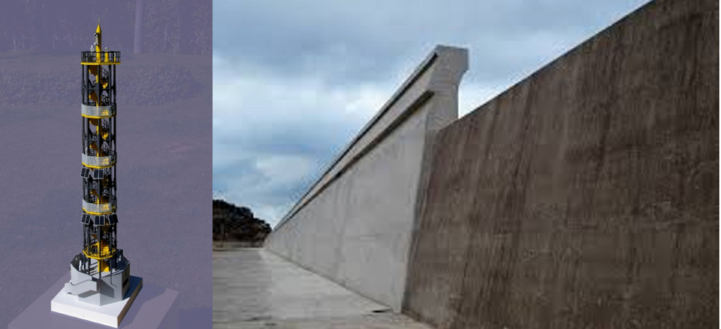
Figure 13. Composite materials lighthouse in Valencia (2015) and screed of the crown wall in Escombreras with FRP (2017) (source: own